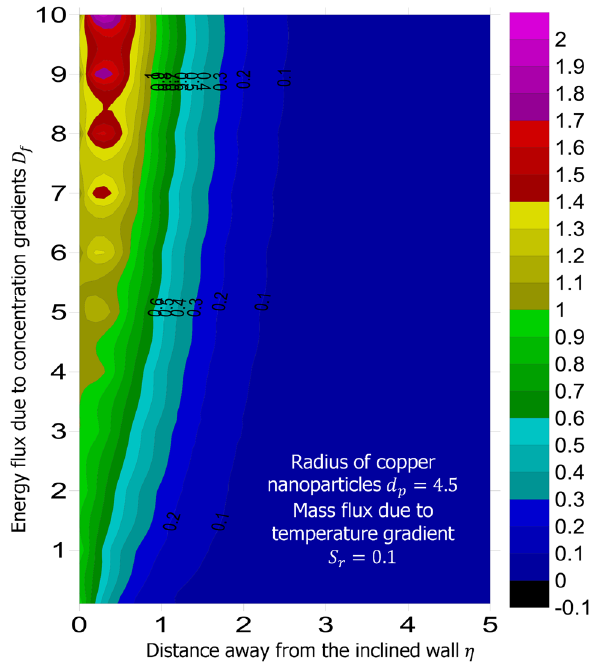
Figure 5. Variation in shear stress within the domain due to d p at various values of d f .